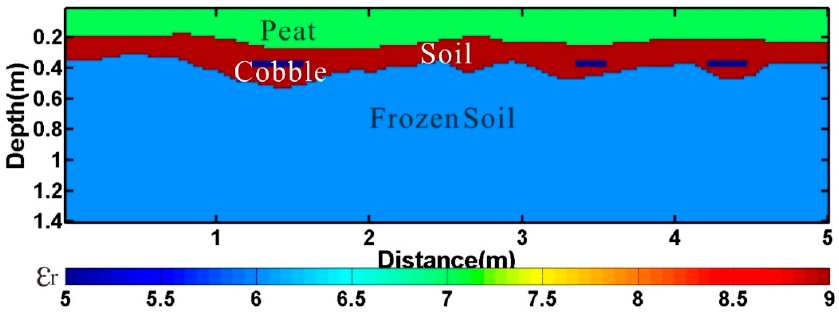
Figure 7. The relative dielectric constant model was designed using the L1 line RTM profile.